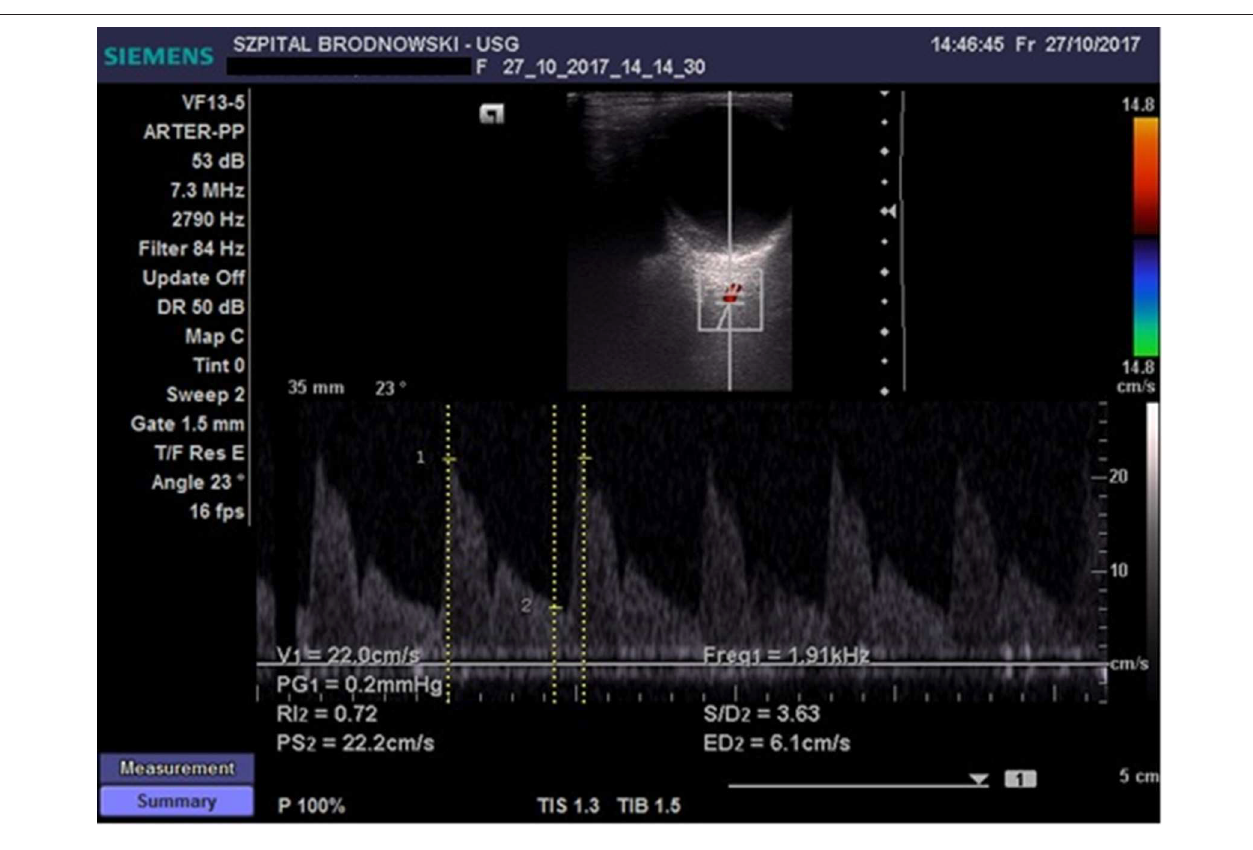
FIGURE 3 | Flow velocity waveform in the ophthalmic